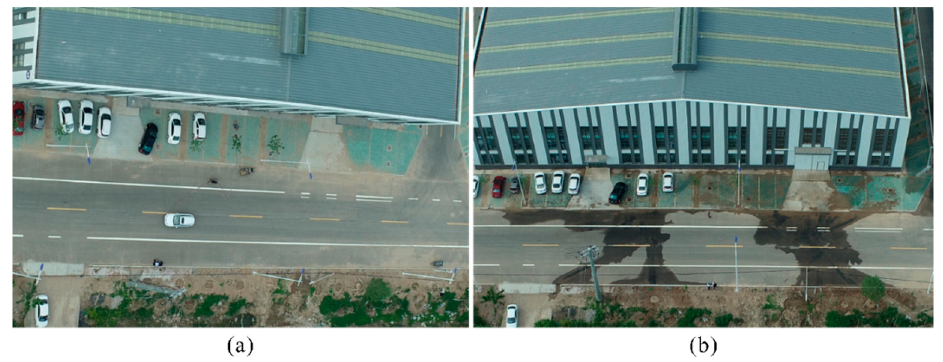
Figure 8. Best view ID of the simplified mesh facets: ( a ) whole drawing; ( b ) partial enlarged drawing.